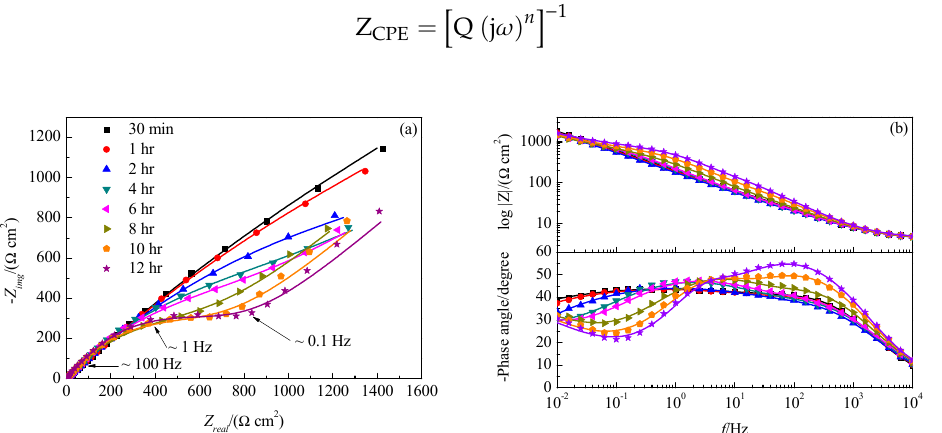
Figure 8. Nyquist ( a ) and Bode ( b ) impedance plots of copper electrode in neutral 3.5% (wt.) NaCl